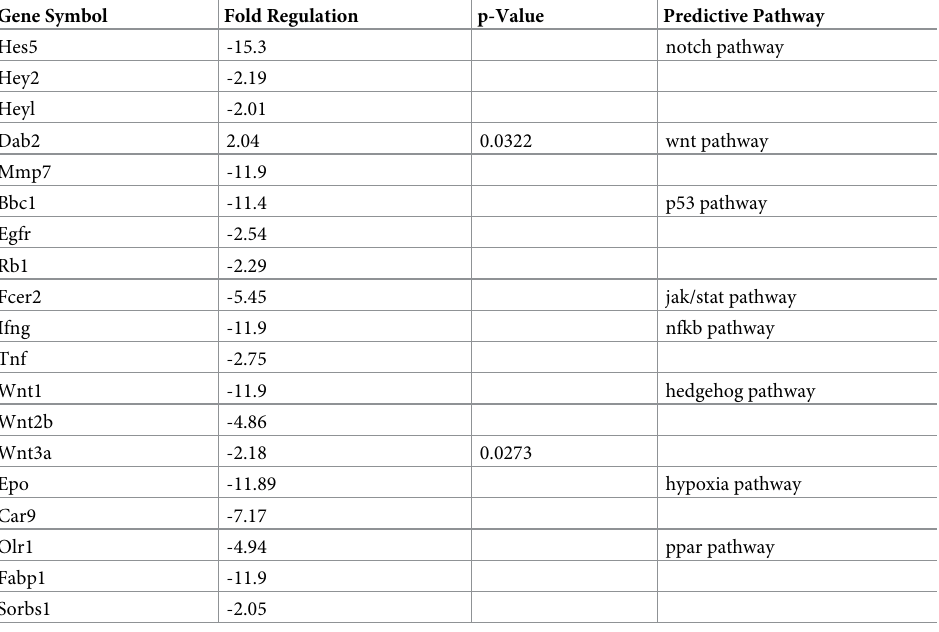
Table 3. Genes expressed following 532 nm laser exposure at low irradiance of 0.5 W/cm 2